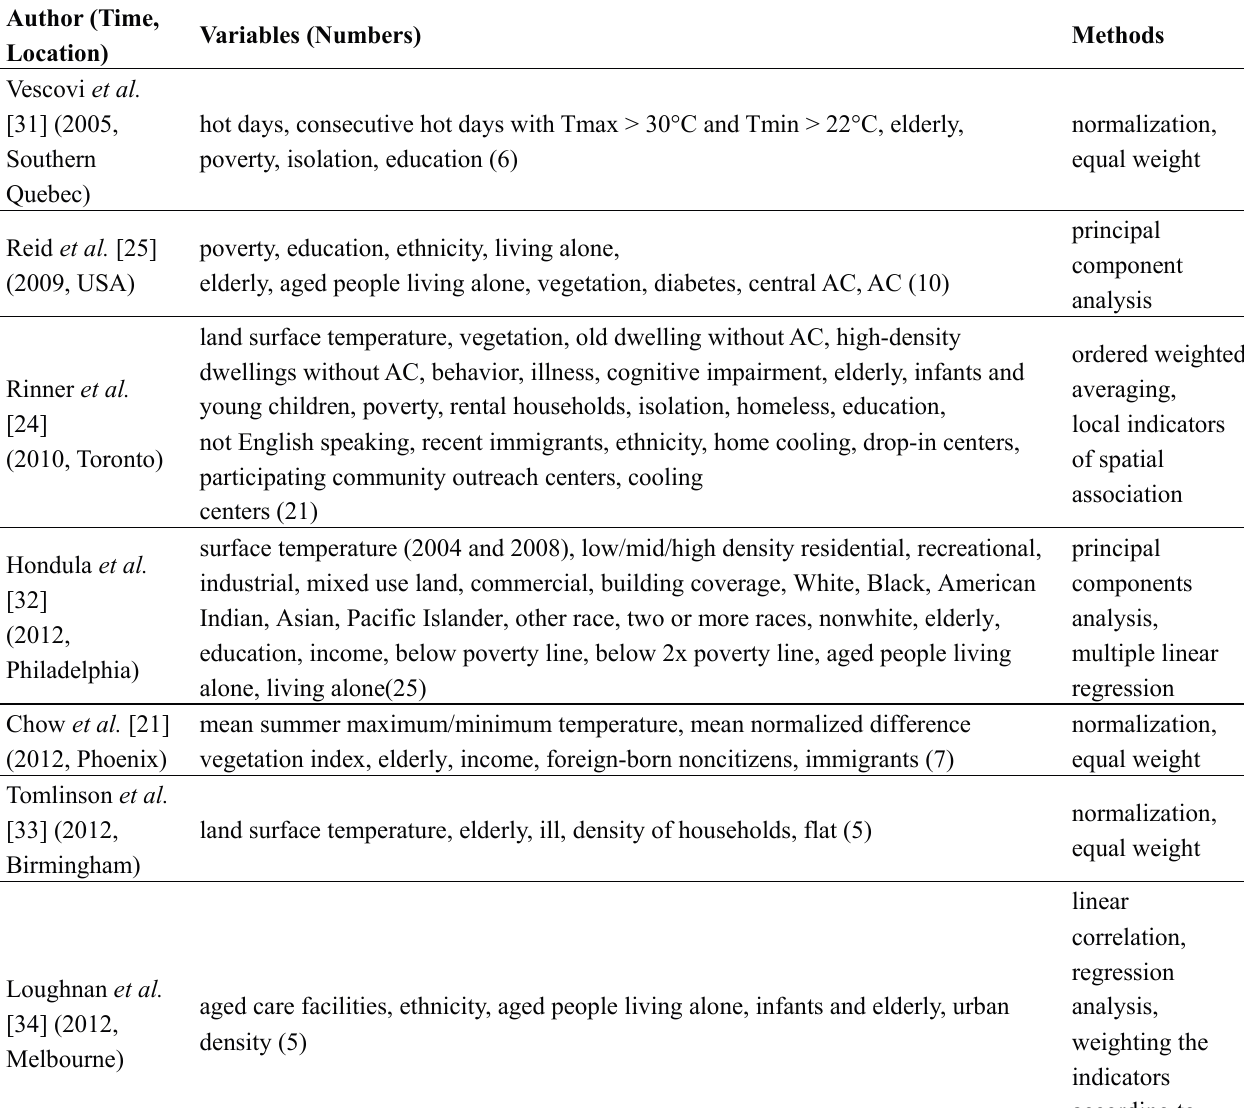
Table 1. Summary of the studies about heat vulnerability